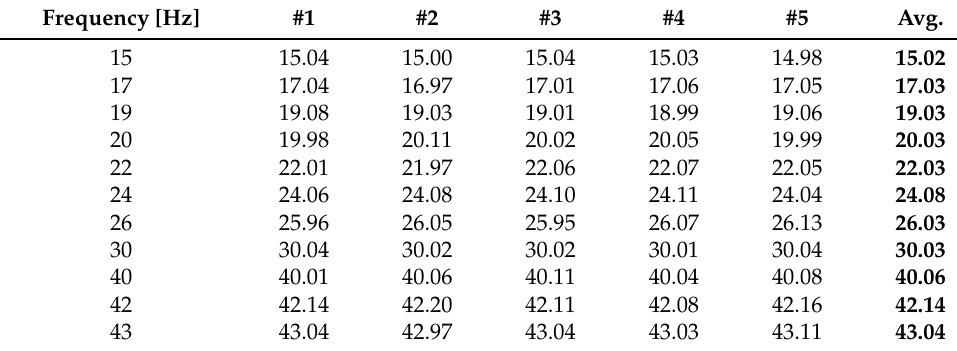
Figure 10. FFT output for combined signals. Table 3. Frequency detection